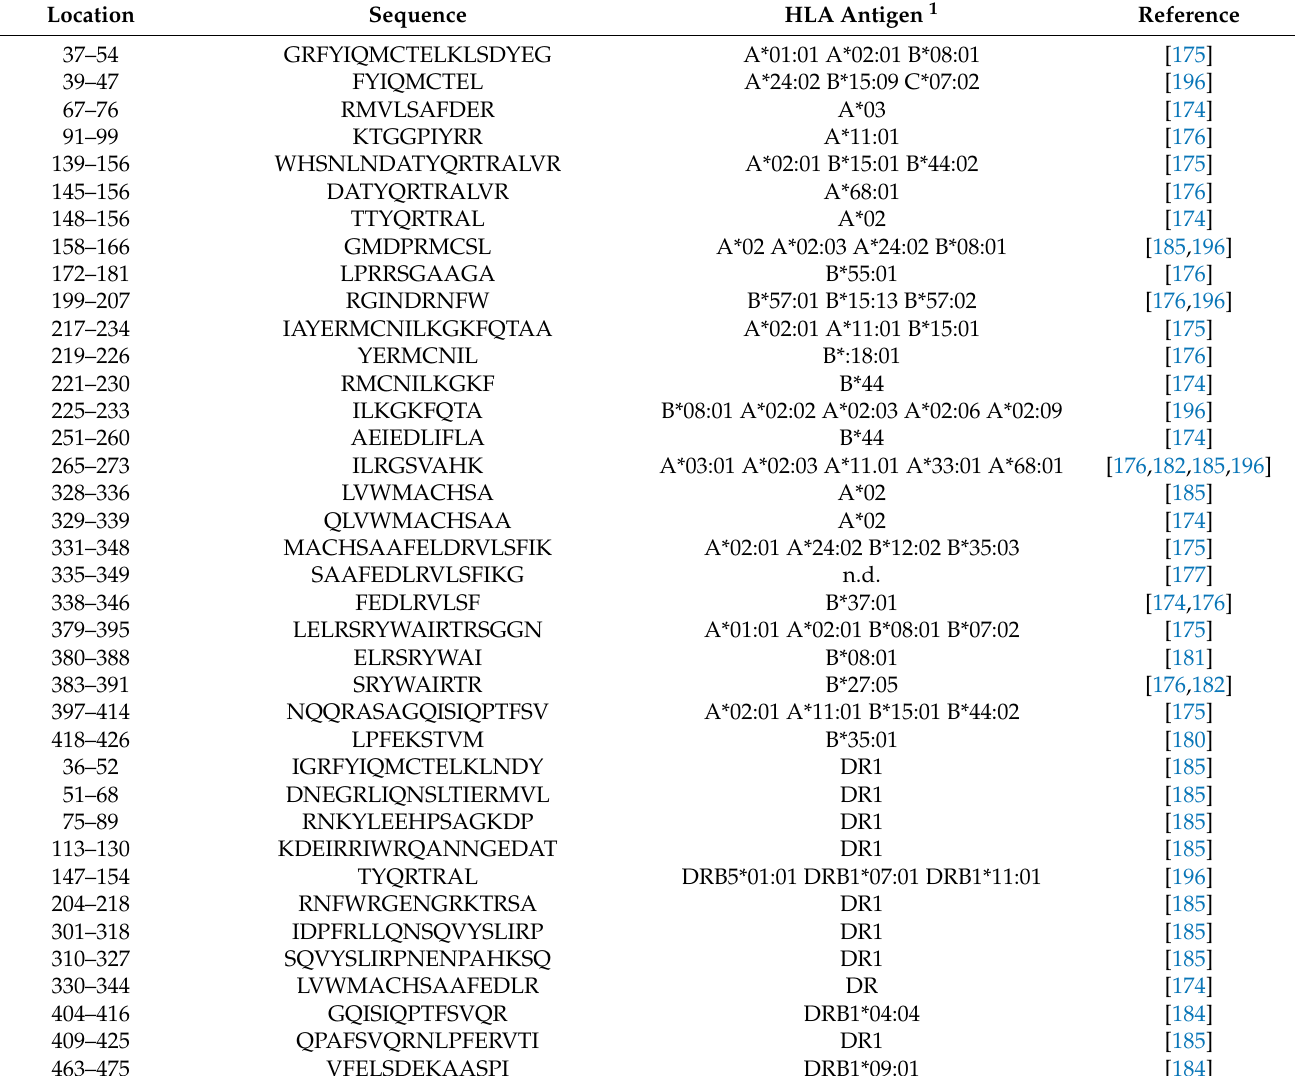
Table 3. T-cell epitopes of influenza A virus